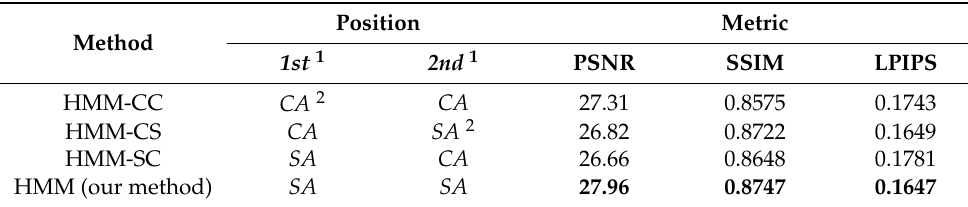
Table 3. Metric values (PSNR/SSIM/LPIPS) of the proposed HMMs with different attention mecha- nisms. Our method uses the spatial attention in all attention units of HMM. Best results are marked in bold.